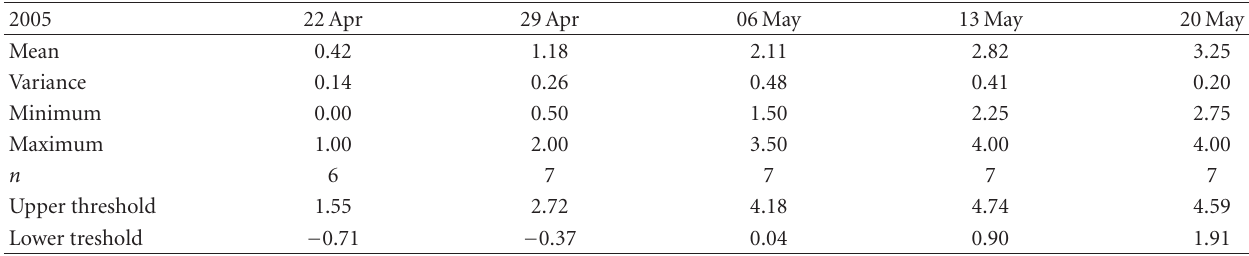
Table 3: Results of Descriptive Analysis. Year 2005.